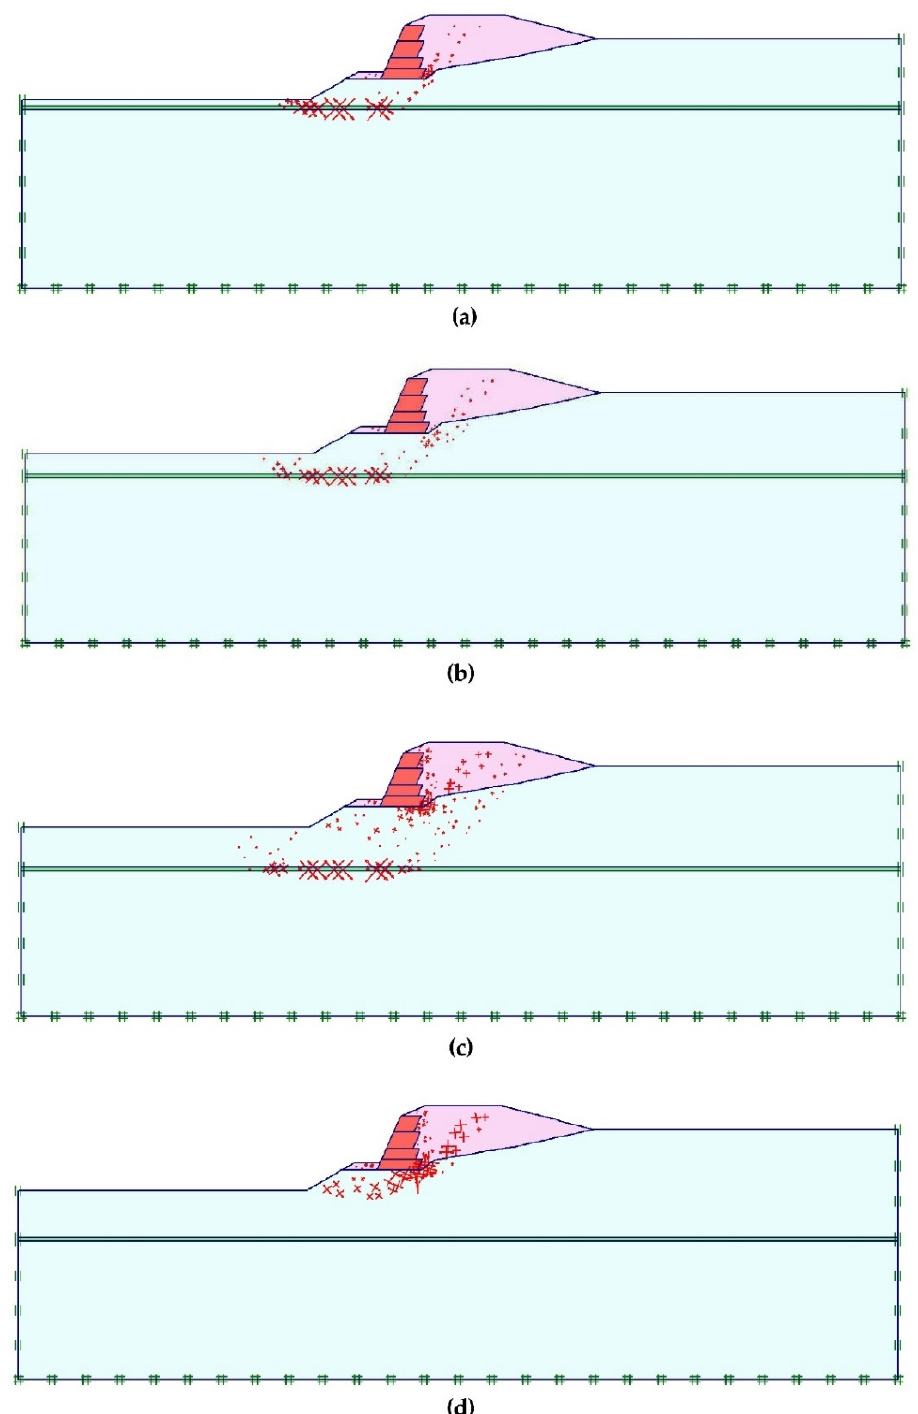
Figure 6. Total strain at failure for the case of the horizontal weak layer with c ′ 2 = 0.2 kPa and φ′ 2 = 10° located at depth equal to ( a ) z i = 4 m (z i /H = 0.47), ( b ) z i = 6 m (z i /H = 0.71), ( c ) z i = 9 m (z i /H = 1.06) and ( d ) z i = 10 m (z i /H = 1.18).